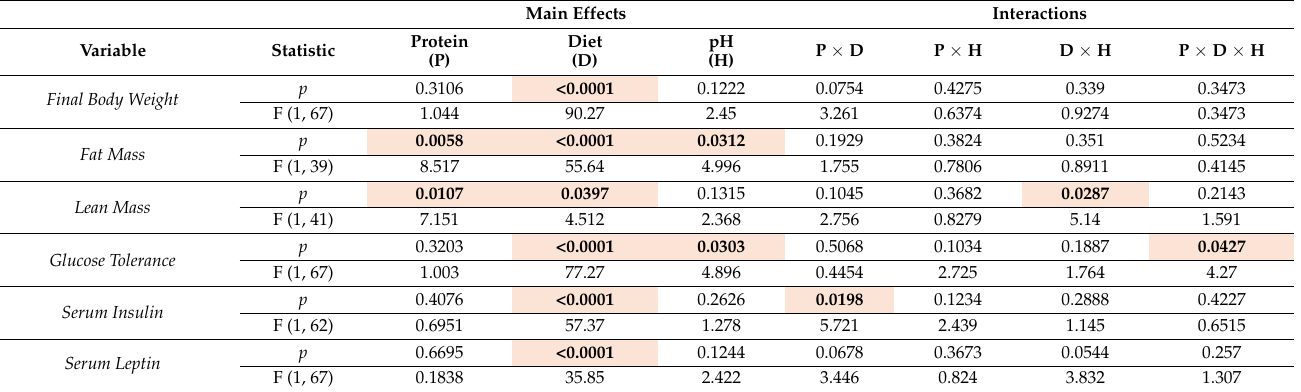
Table 1. Effects of protein, diet, and pH on body weight and body composition, glucose tolerance and serum markers in B6 male mice. p and F values of three-way ANOVA to evaluate main effect and